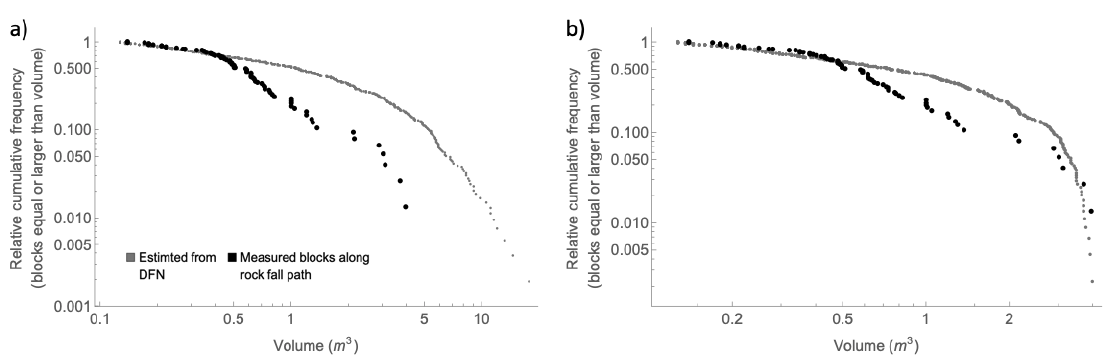
Figure 7. Fragmented rockfall volume cumulative relative distribution as calculated by the persistent DFN method and field surveys, for all DFN calculated volumes ( a ) and for DFN volumes truncated in accordance with the range of surveyed volumes ( b ). Tornado Mountain.